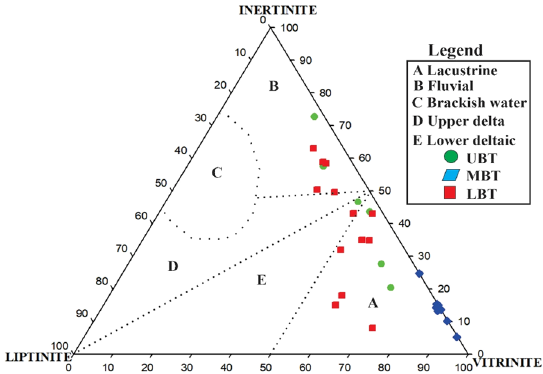
Fig. 6 Coal facies diagram proposed for the coal studied (samples 01 and 17 are excluded), modified after Teichmüller